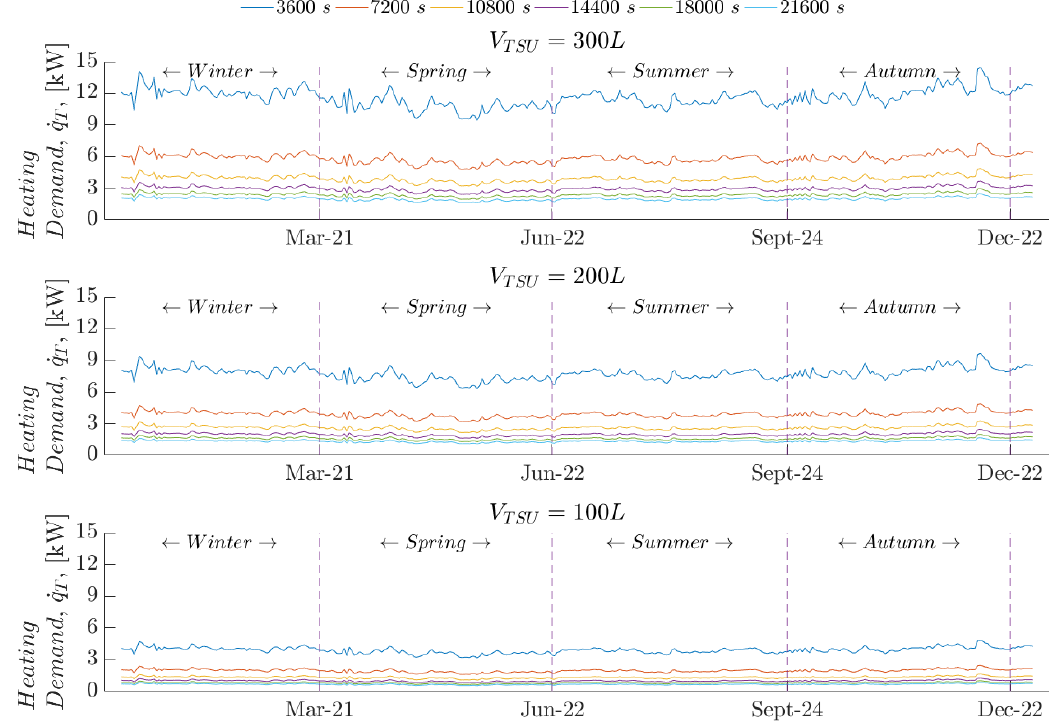
Figure 12. Compression power input for all working fluids throughout the year for all refrigerants.